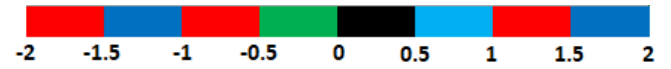
Figure 3. The time lags (in years) within the four-year cycle. In red, the El Niño-Southern Oscillation (ENSO) event is out of phase with the annual quasi-stationary wave (QSW); in green it is unlagged; in light blue it is weakly lagged; and in dark blue it is strongly lagged. Black represents the forbidden lag (no event can occur).